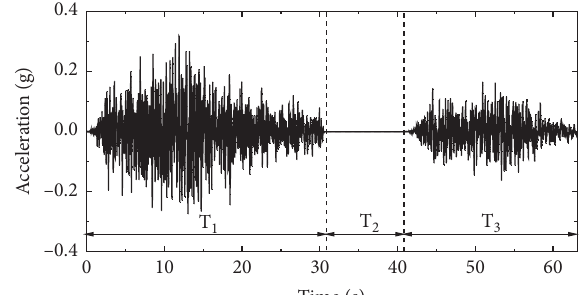
Figure 4: Horizontal seismic wave acceleration time history curve.